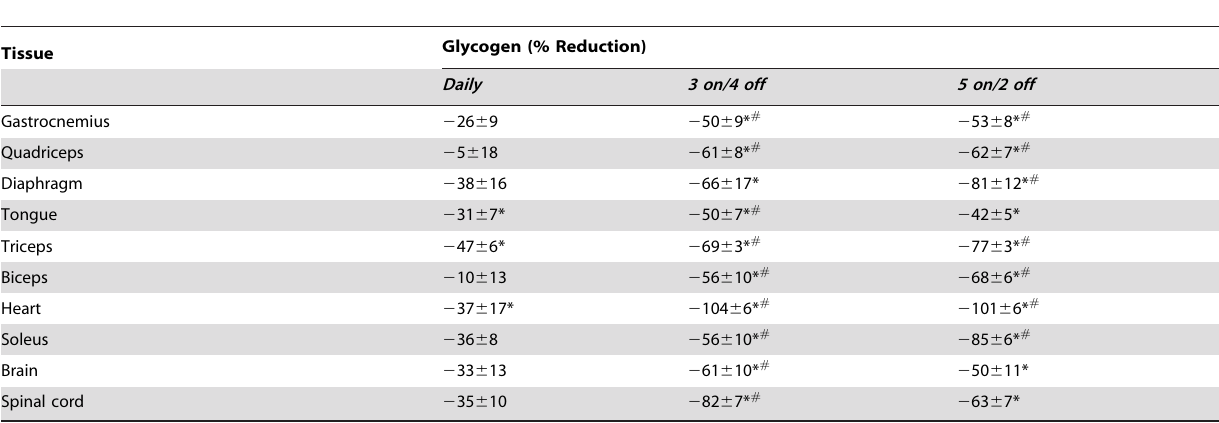
Eight-week old male hP545L GAA Tg/KO mice were administered 100 mg/kg AT2220 ad libitum in drinking water for four weeks using the indicated regimens. Tissue glycogen levels were determined as described in ‘‘Materials and Methods’’. The glycogen levels were normalized relative to baseline levels of untreated hP545L GAA Tg/ KO (100%) and wild-type mice (0%). *p , 0.05 compared to baseline; # p , 0.05 compared to daily, as determined by t-test. Values represent the mean 6 SEM for 7 mice per